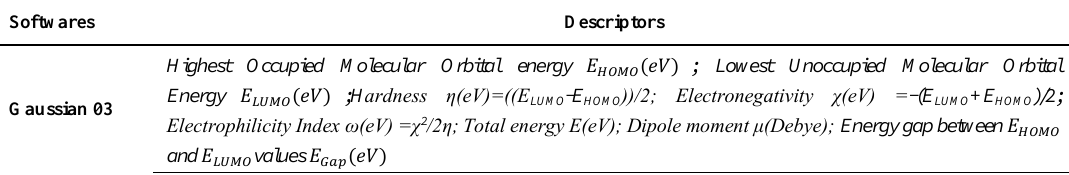
Table 2. Descriptors selected and software packages used in the calculation of